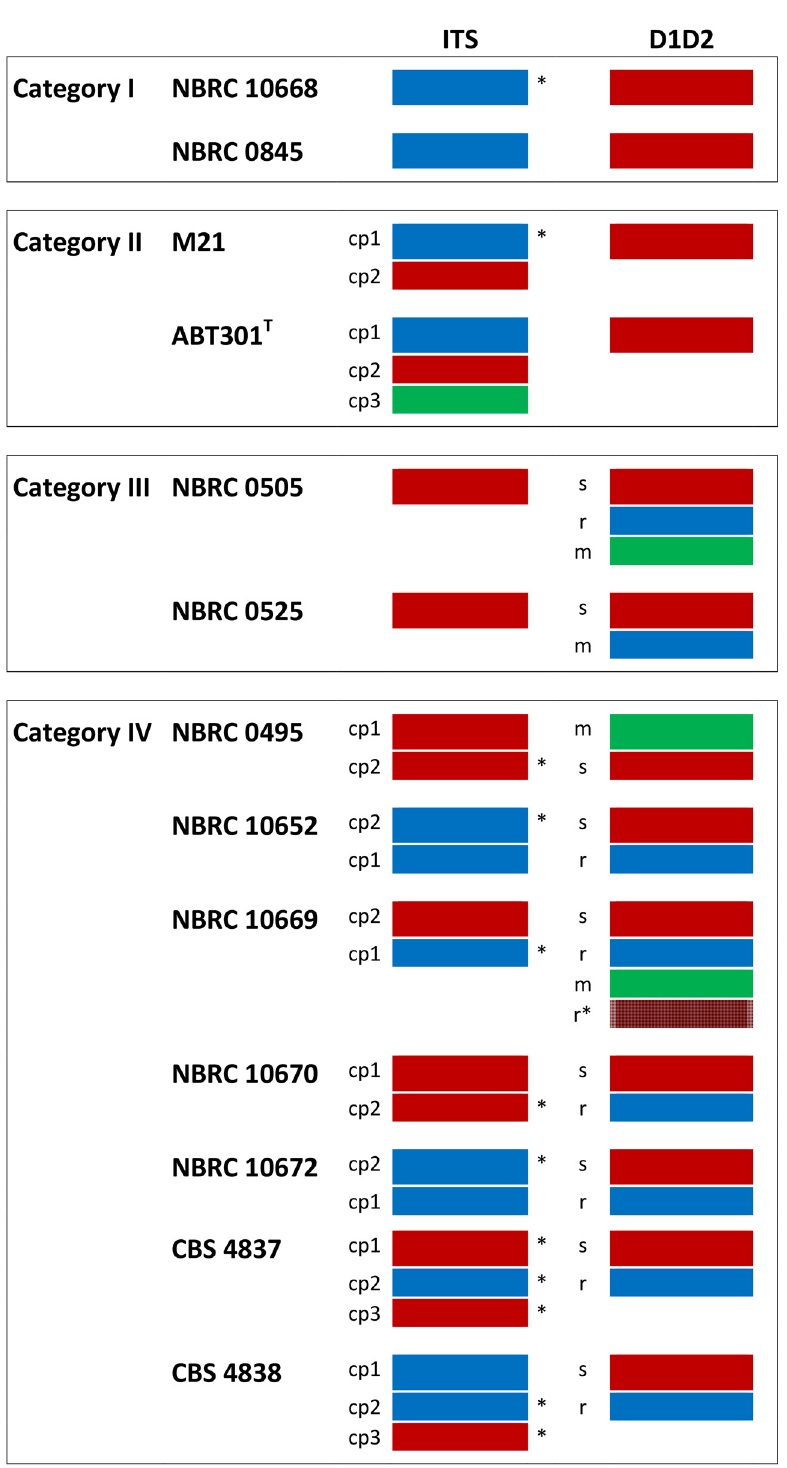
Fig 6. Patterns of ribosomal homogenization detected in Z . rouxii complex strains. Four evolutionary outcomes (or categories) result from homogenization of divergent intra-genomic ribosomal variants. Red, blue and green rectangles mark Z . sapae , Z . rouxii and Z . mellis ribosomal sequences, respectively; asterisks mark ITS sequences partially divergent from Z . sapae and Z . rouxii (minor clusters Z . sapae -like and Z . rouxii - like, according to Fig 2). r, s, and m indicate Z . rouxii , Z . sapae , and Z . mellis D1/D2 copy variants, respectively. Abbreviation: cp,